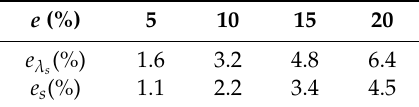
Table 3. Influence of stochastic error e in the measured data on the relative error of the identified conductivity of nanometer-sized skeleton and specific area.